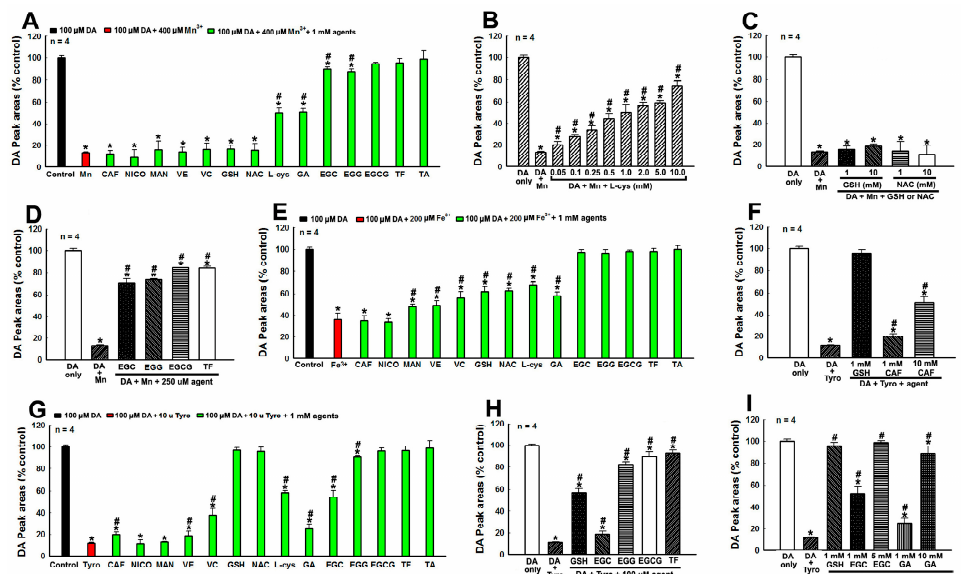
Figure 1. Protections against factors induced dopamine (DA) oxidation by tea polyphenols and other agents. The oxidation of 100 µ M DA is induced by 400 µ M Mn 3 + , 200 µ M Fe 3 + and 10-unit Tyro respectively for 3 min at room temperature in the presence or absence of various agents before HPLC analysis of DA content in solutions. Freshly prepared DA is set as control and DA peak areas are expressed as % control. *, at least p < 0.05, compared with DA peak areas of controls. #, at least p < 0.05, compared with peak areas of DA after Mn 3 + , Fe 3 + and Tyro induced DA oxidation respectively in the absence of protective agents. ( A – D ), Protection against Mn 3 + induced DA oxidation by di ff erent agents. ( A ) Protection by 1 mM agents. ( B ) Dosage dependent protection by L-cys. ( C ) glutathione (GSH) and N-acetyle-cysteine (NAC) cannot protect against Mn 3 + induced DA oxidation. ( D ) Protection by 250 µ M tea polyphenols. ( E ) Protection against Fe 3 + induced DA oxidation by 1 mM agents. ( F – I ), Protection against tyrosinase induced DA oxidation by various agents. ( F ) Dosage dependent protection by CAF. ( G ) Protection by in 1 mM agents. ( H ) Protections by 100 µ M tea polyphenols. ( I ) Dosage dependent protection by epigallocatechin (EGC) and GA.